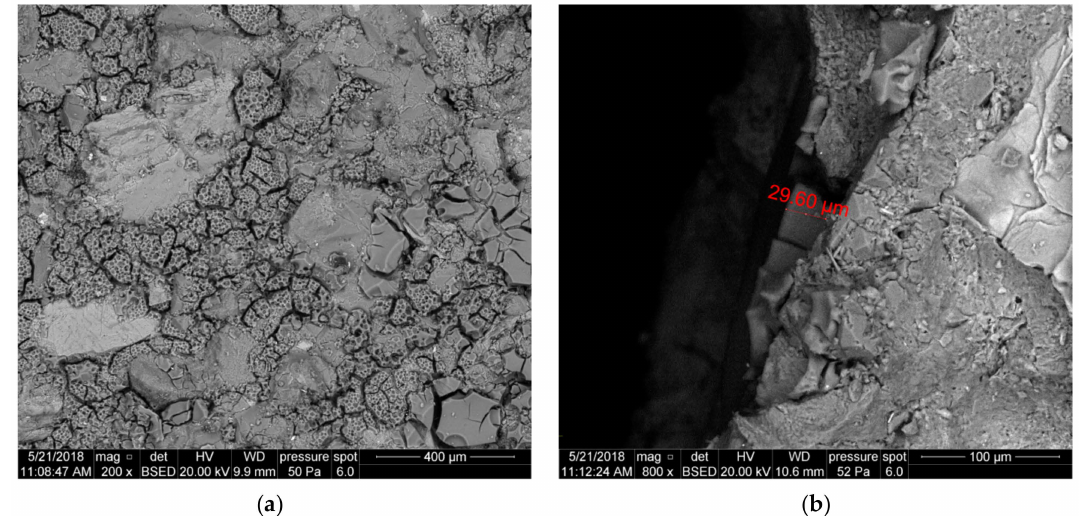
Figure 12. SEM image of the 3224 core face after contact with foamed U-2 S.F. 2b, ( a ) top view of the core face, ( b ) side view of the core face.